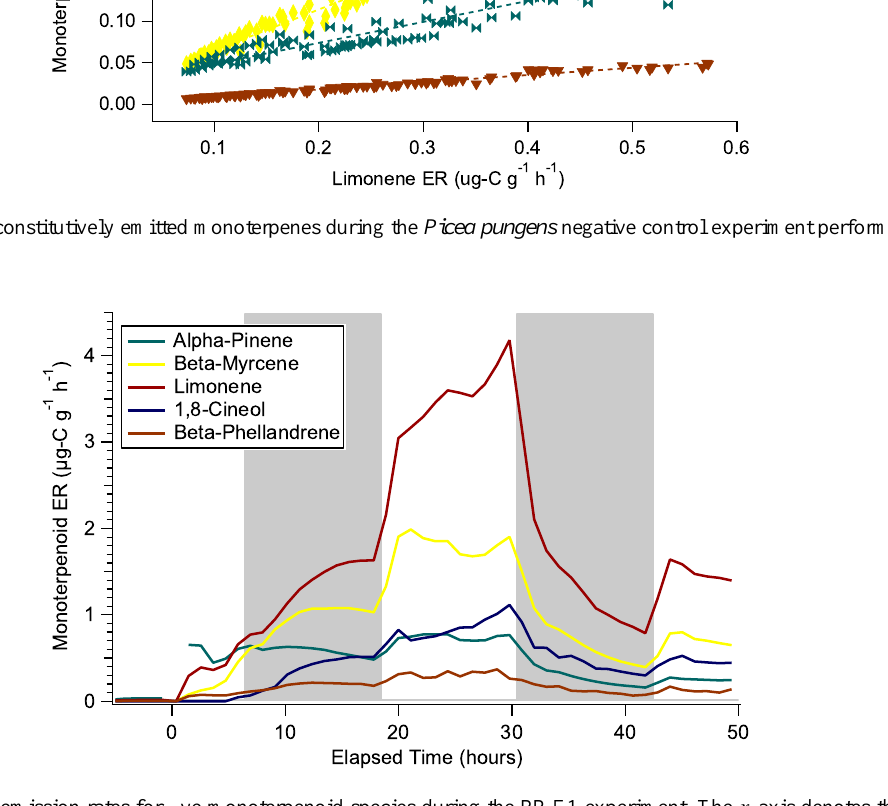
Figure 5. Post-treatment emission rates for five monoterpenoid species during the PP-E1 experiment. The x axis denotes the elapsed time since treatment application in hours. Alternating shaded and unshaded regions demonstrate when the light above the plant enclosure was turned off and on,